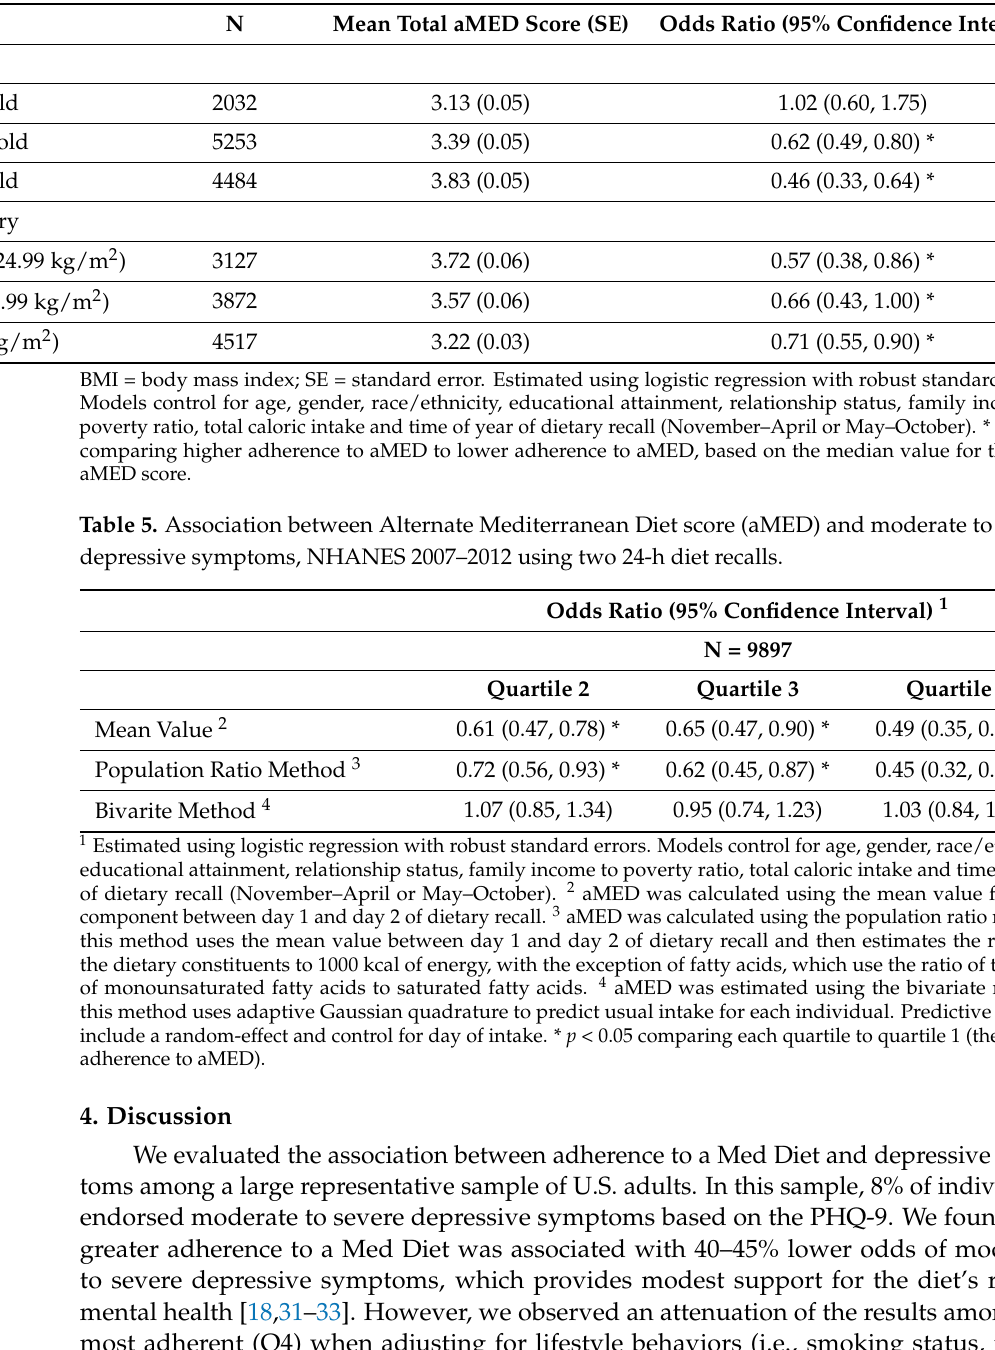
Table 4. Heterogeneity in the association between Alternate Mediterranean Diet score (aMED) and moderate to severe depressive symptoms, NHANES 2007–2012.